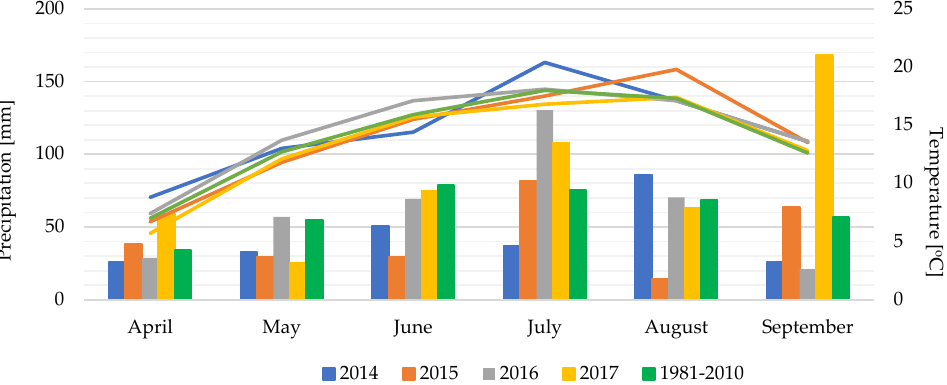
Figure 1. Meteorological conditions during 2014–2017 period. Meteorological data against the years 1981–2010 (Data obtained from the Meteorological Station at Tomaszkowo (53°71 ′ N, 20°30 ′ E), Po- land.